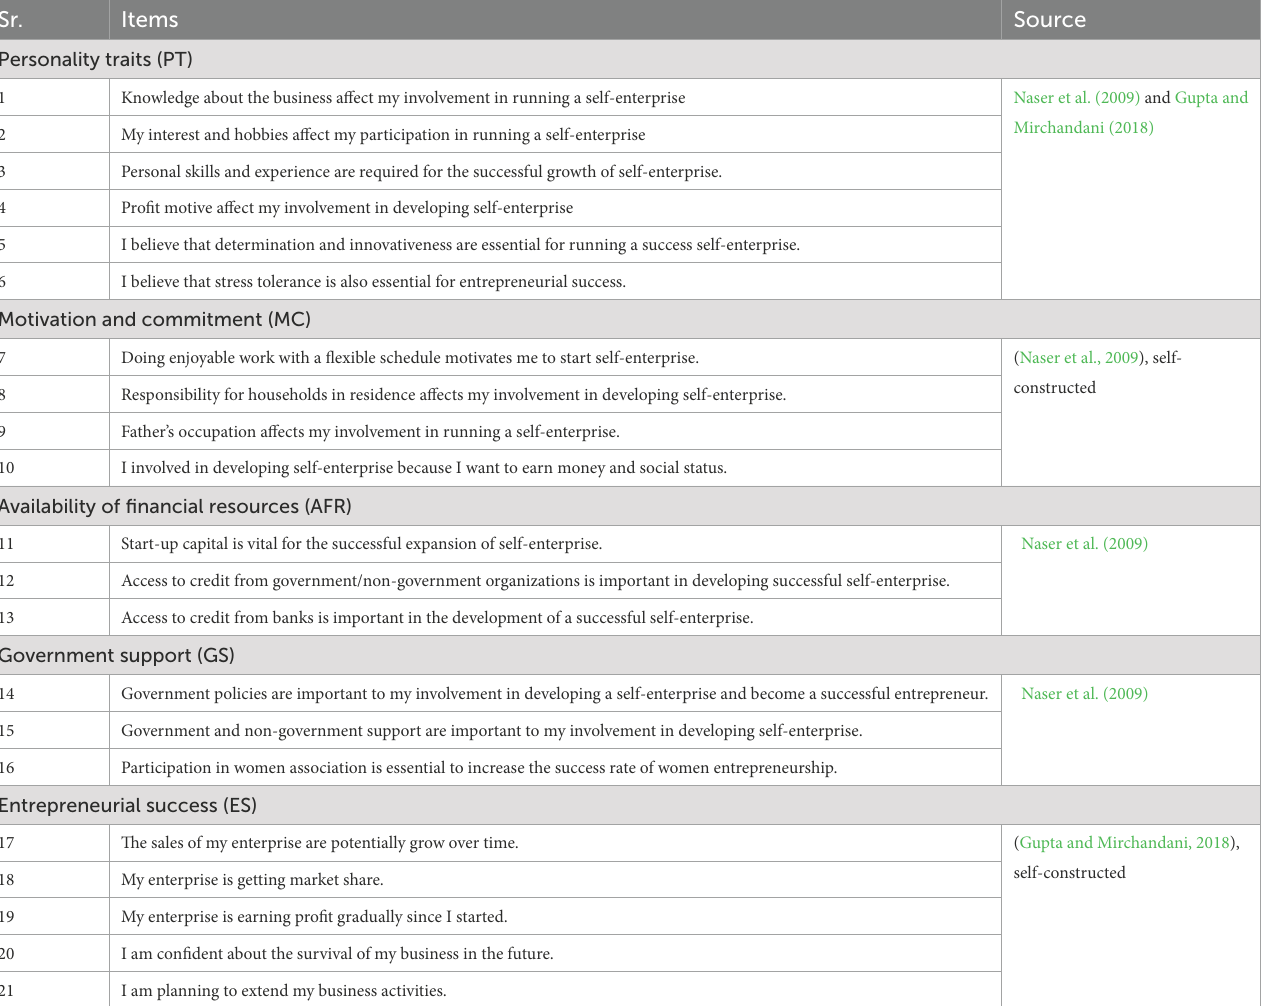
TABLE 1 Survey questionnaire.